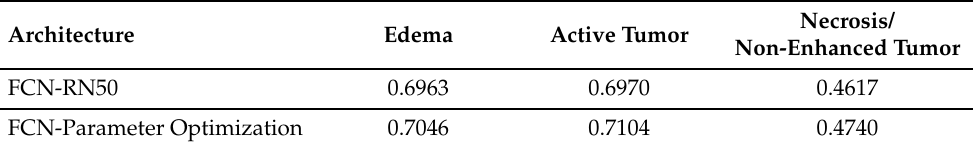
Table 5. Dice for Different Types of Tumor Tissues (Edema, Active Tumor, and Necrotic Tumor) with Parameter Optimization.